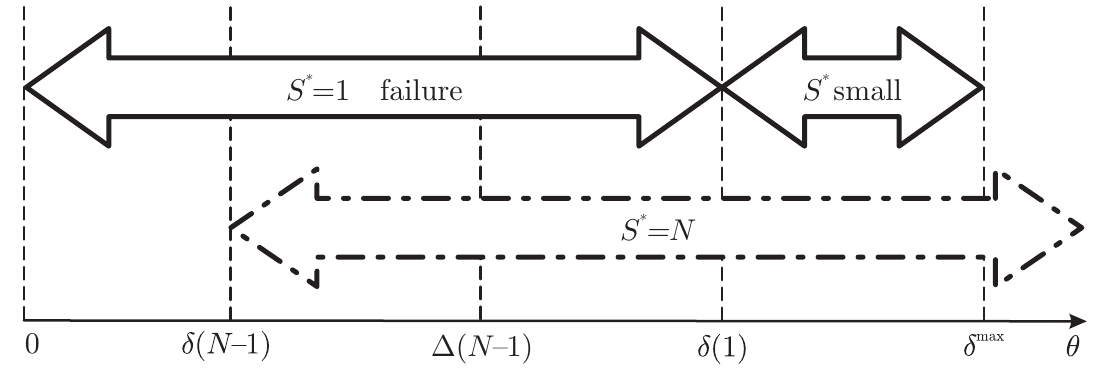
Figure 6. Equilibria without all-but-one for N ≥ 28